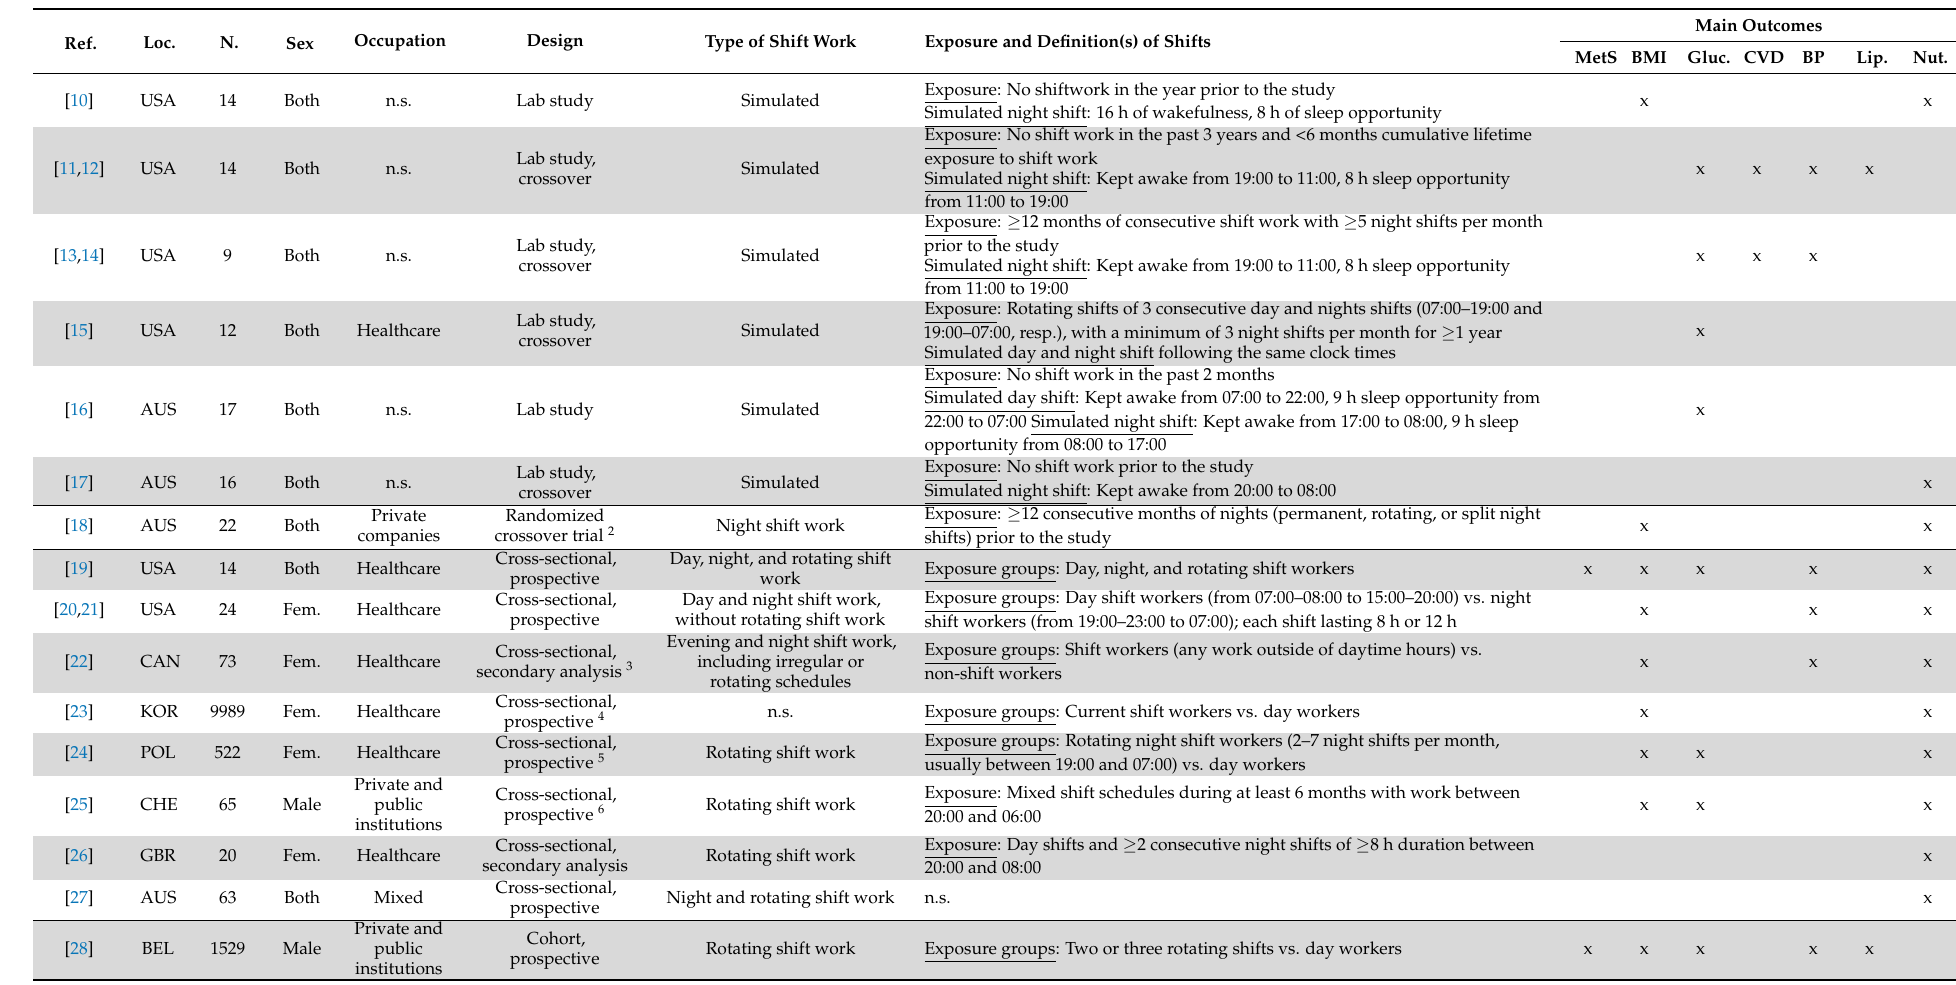
Table 1. Population, design, shift work definition(s) and exposure, and main outcomes of the reviewed studies 1 .